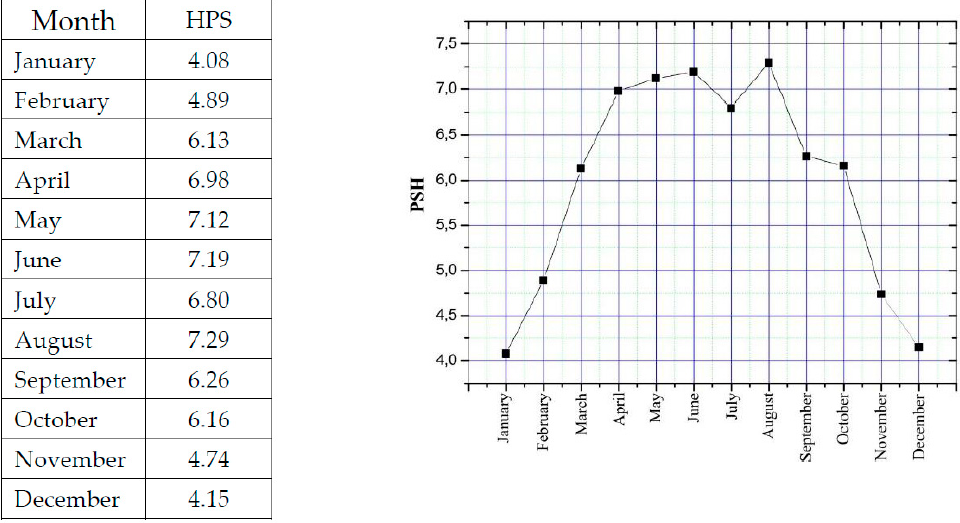
Figure 4. Average solar peak hours (PSH) for each month of the year (2010–2017).